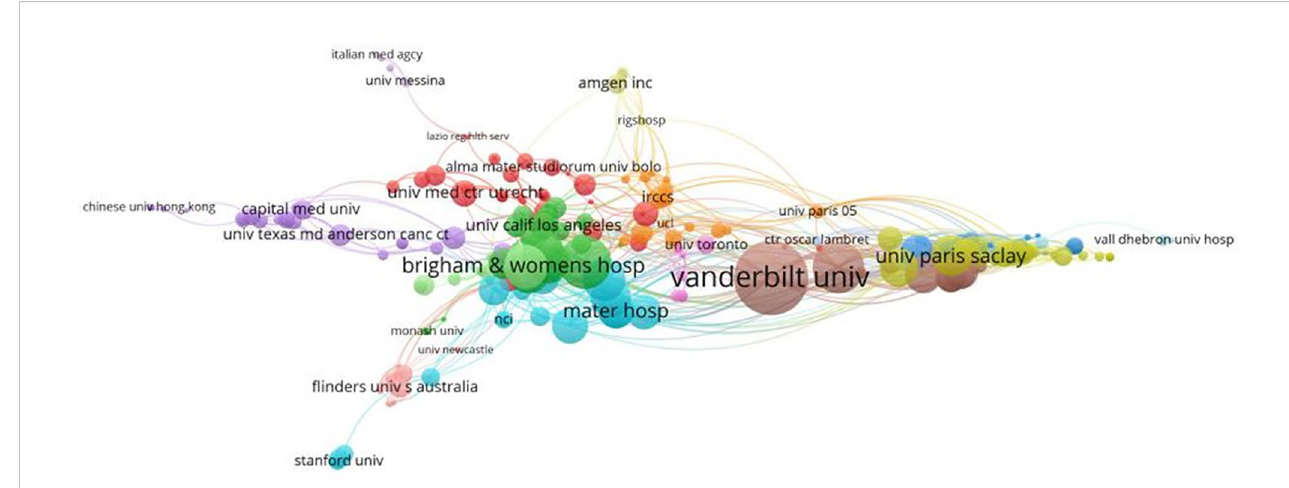
FIGURE 4 Cluster maps of the institutions. Nodes represent institutions. Node size is proportional to the contribution of the institution. Clusters of the same color imply more active cooperation. The line between nodes represents cooperation between institutions.